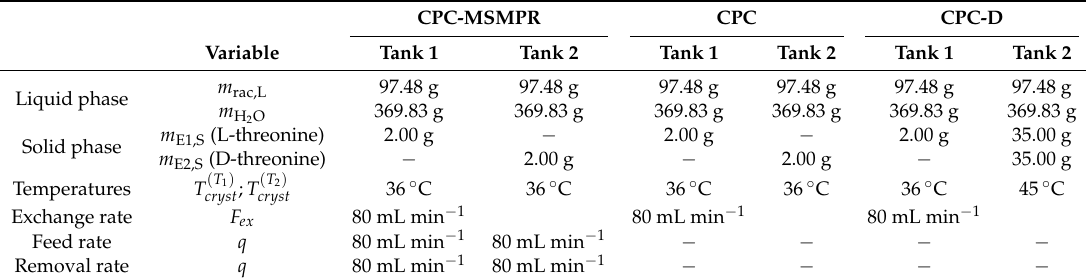
Table 1. Process conditions used in simulation studies for coupled preferential crystallization in coupled preferential crystallization-dissolution (CPC-D) in batch